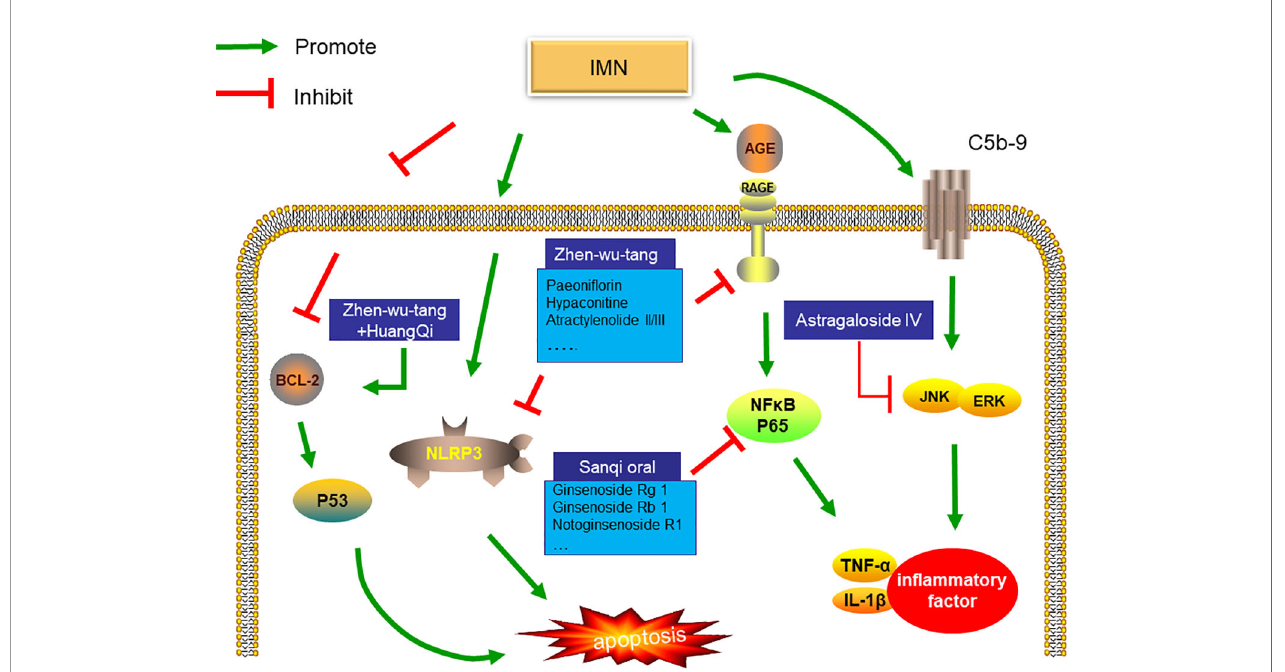
FIGURE 1 | Mechanism of Chinese medicine treatment of IMN. Zhenwu decoction combined with Astragalus can also directly promote the expression of Bcl2 and inhibit the transcription of P53 to reduce cell apoptosis. In addition, zhenwu decoction reduce the pro-oxidation ability of AGE by down-regulating the expression of receptor AGE(RAGE) in podocyte, which reduce oxidative stress in podocyte. Not only that, Zhenwu decoction can reduce the expression of pro-in fl ammatory factors by inhibiting the level of NF- k B and NLRP3,which will reduce cell apoptosis sanqi oral which mainly include Radix Astragalus membranaceus and Radix Notoginsen not only decrease in fl ammatory factors by inhibiting the level of NF- k B, but also reduce deposition of C3 and IgG in experimental rat model of membranous nephropathy induced by cationic Bovine Serum Albumin (C-BSA). Astragaloside IV can attenuates complement membranous attack complex induced podocyte injury through decreasing the expression of